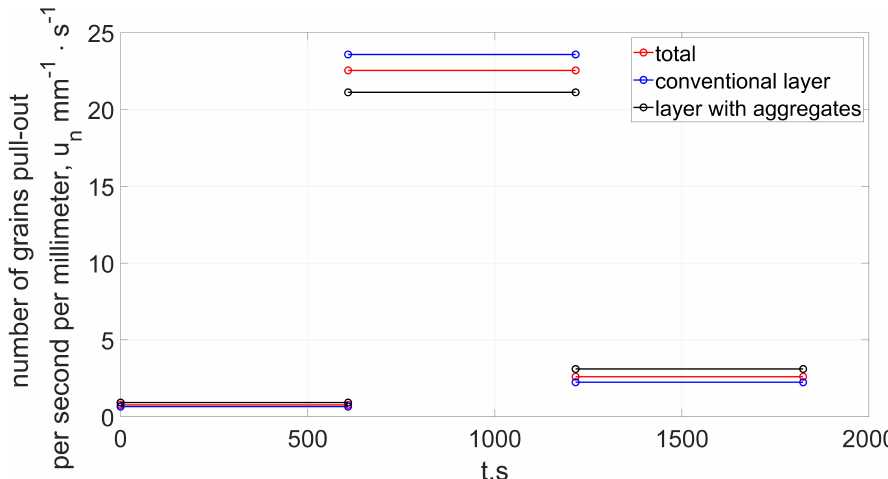
Figure 8. Number of fractured (pulled-out) abrasive grains (Equation